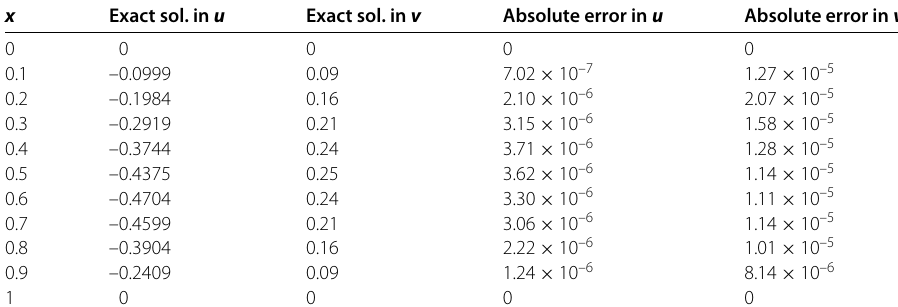
Table 2 Numerical results for Example 1 when N = 40